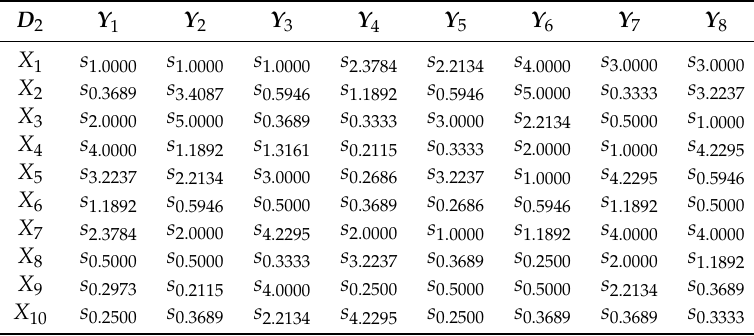
Table A7. Deterministic linguistic evaluation information matrix of D 2 .